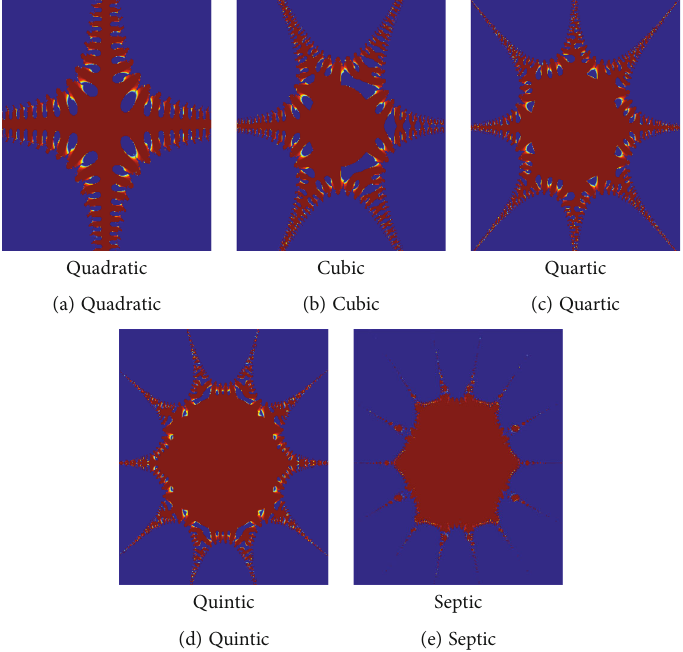
Figure 7: E ff ect of n on Mandelbrot